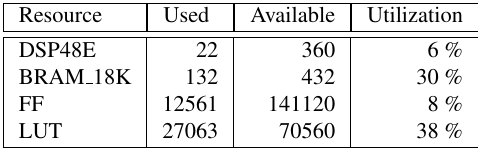
Table 2. Resource utilization with respect to the Zynq Ultrascale+ of the HLS code for disparity